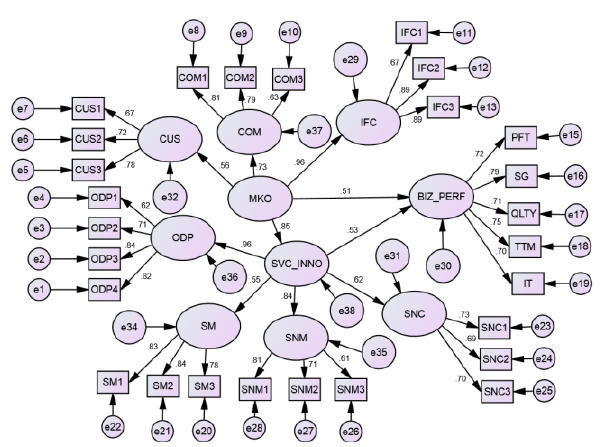
Figure 2: Factor loadings and path analysis in